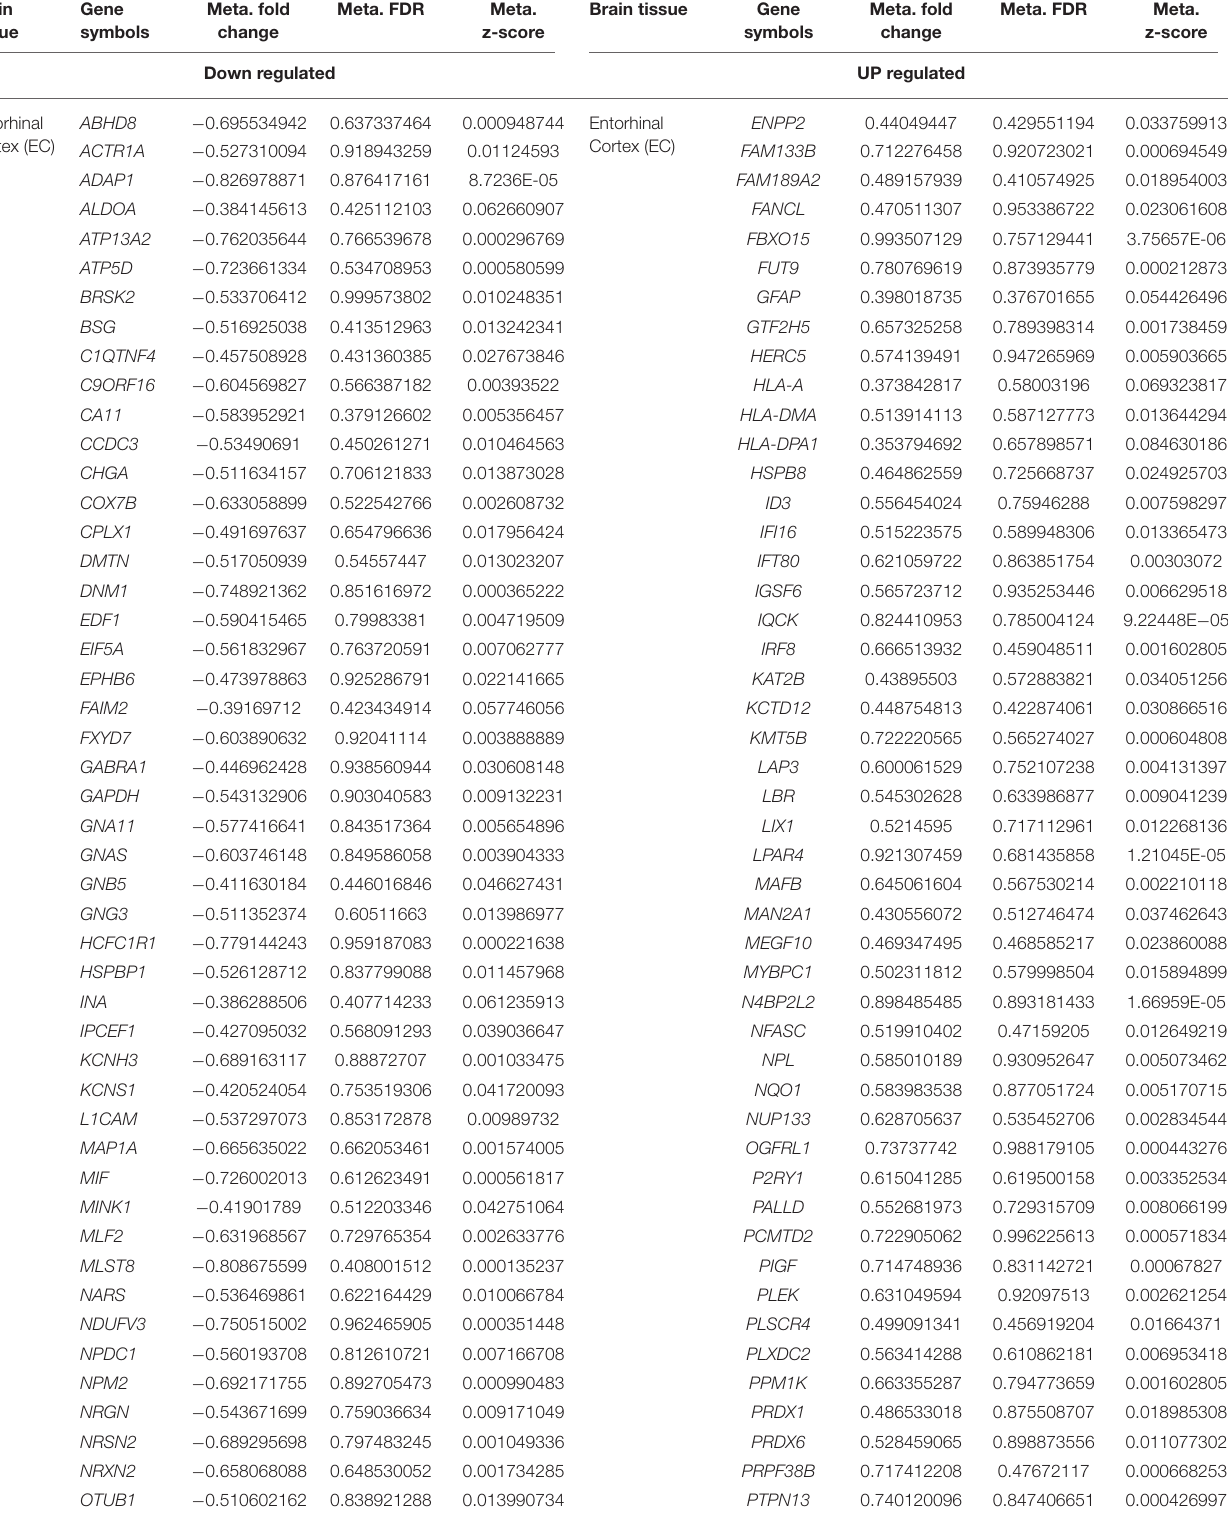
TABLE 3 | Diferentially expressed genes (DEGs) identifed in the meta-analysis of AD